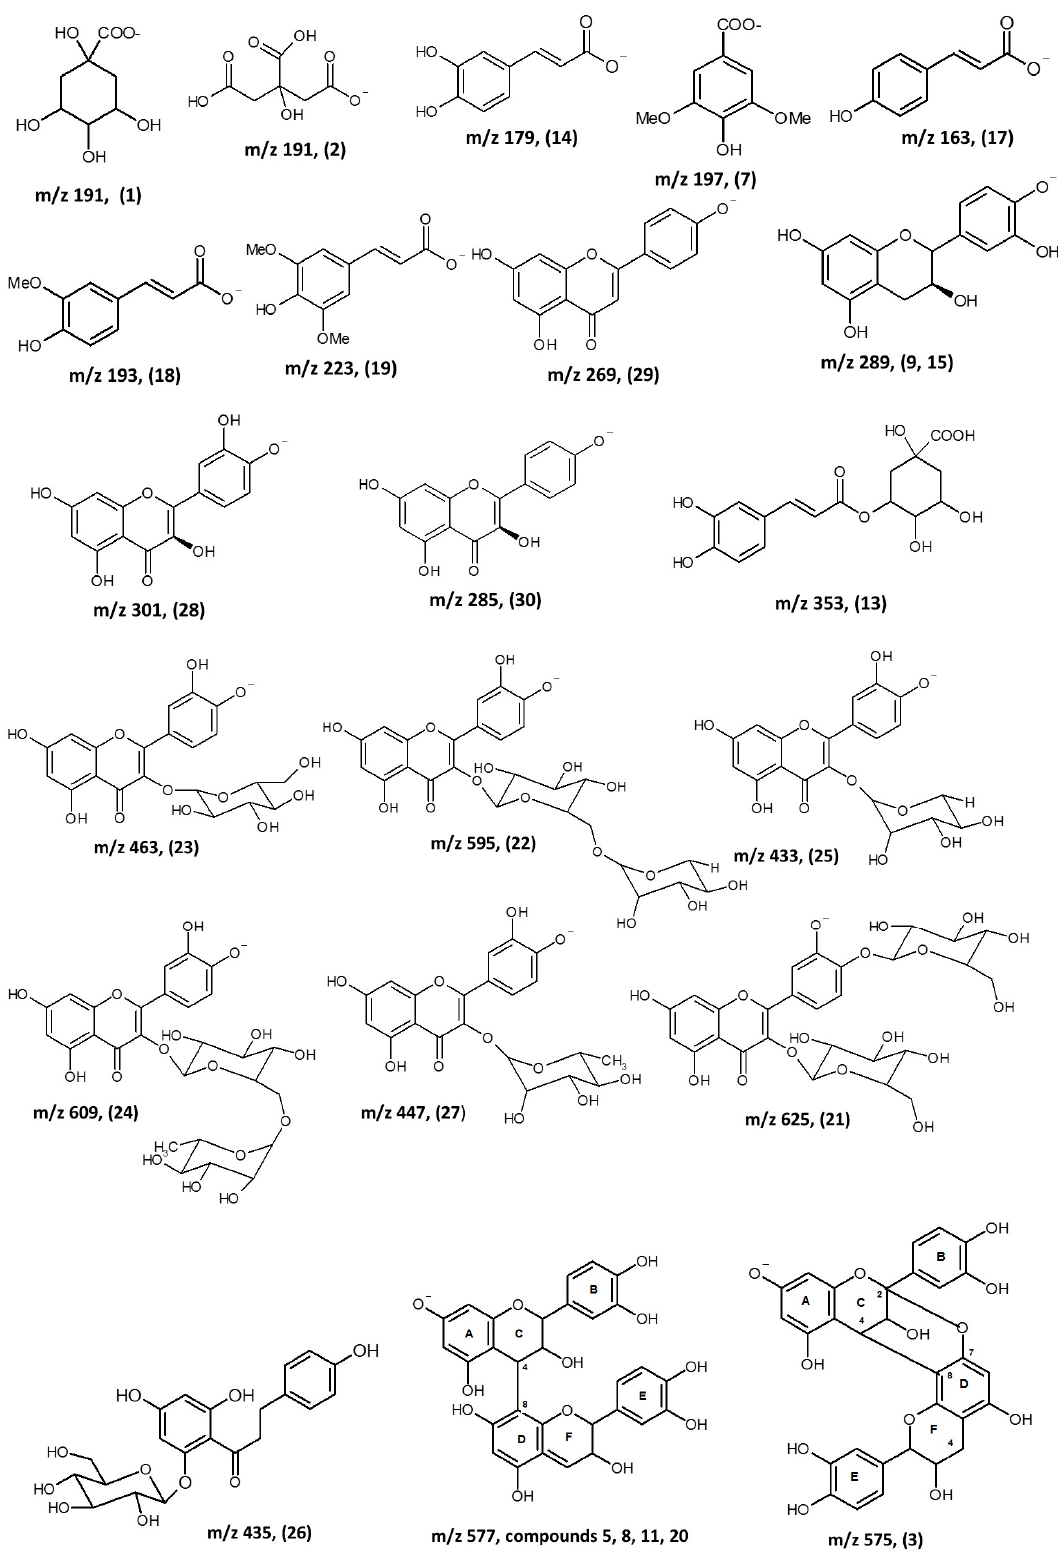
Figure 5. Organic acids, phenolic acids, flavonoids and procyanidin dimers identified in Persea americana Mill. Nariño cultivar.